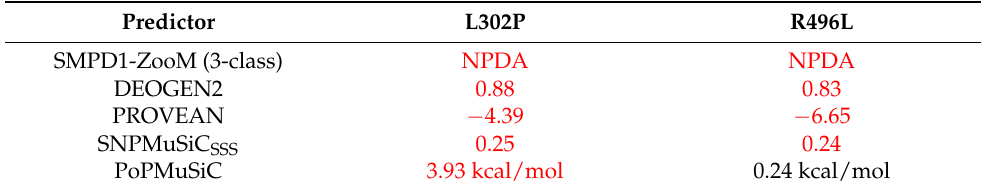
Table 4. Molecular-effect predictions of the missense variants commonly found in populations of AJ ancestry by various deleteriousness predictors used in this study, as well as by the ∆∆ G predictor PoPMuSiC. Red values mean deleterious for all predictors but PoPMuSiC for which it means destabilizing; the ∆∆ G value in black indicate only a marginal effect on